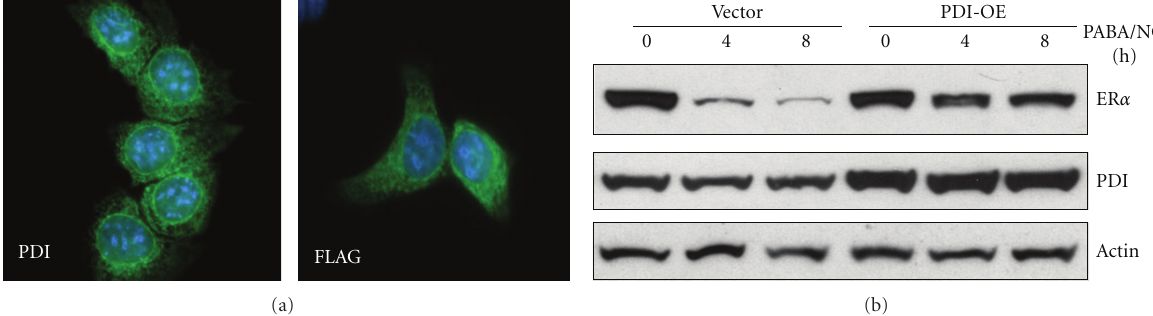
Figure 5: PDI expression levels a ff ect PABA/NO-stimulated ER α degradation. (a) shows fluorescent images detailing similar subcellular distribution of PDI in normal and transfected cells. (b) shows Western blots of vector or PDI-transfected cells treated with PABA/NO for various times. In the transfected cells, over-expression of PDI stabilized intracellular ER α levels, preventing PABA/NO-induced S- glutathionylation from causing Er α degradation.